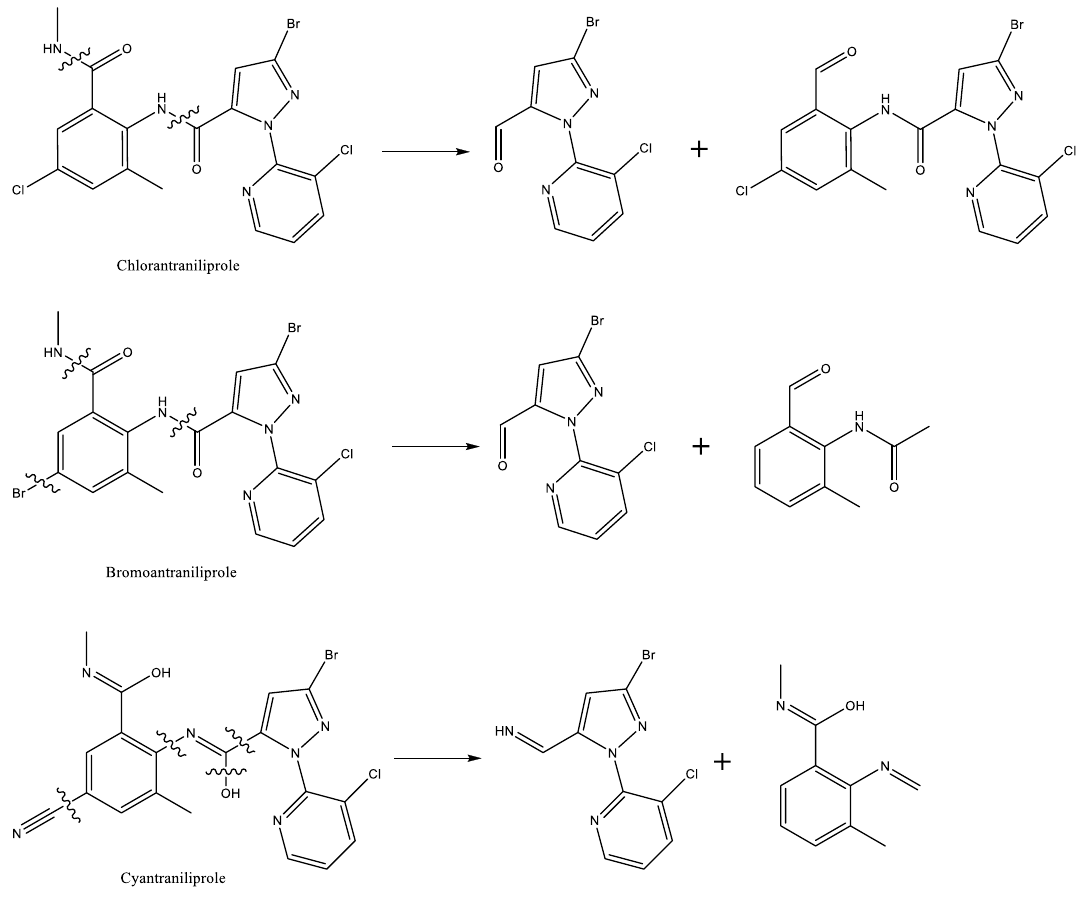
Figure 1. Three amide pesticides broken in positive